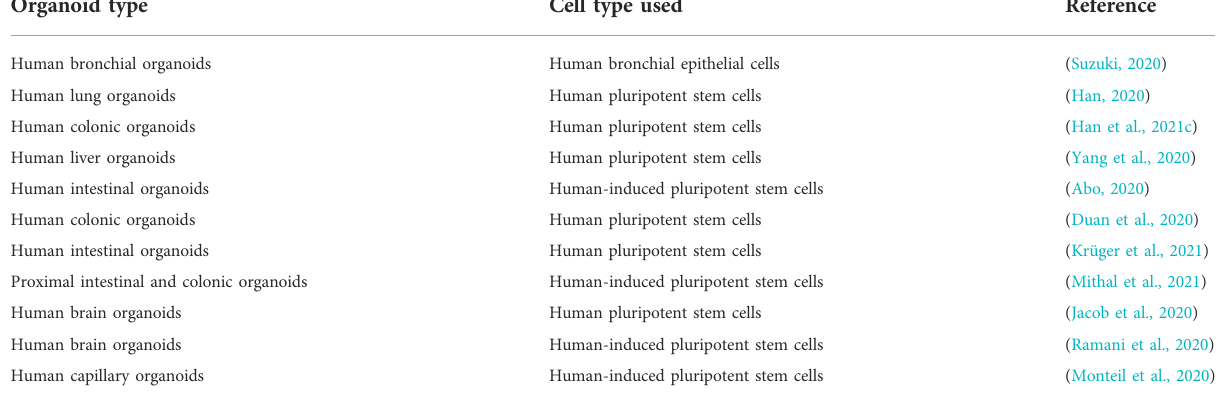
TABLE 2 List of organoid models for COVID-19 modeling using pluripotent stem